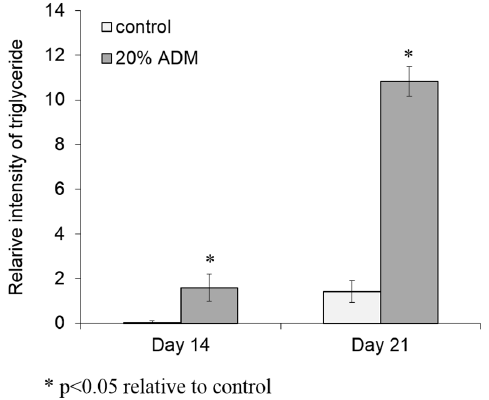
Figure 3. ADM increased triglyceride accumulation in human dermal fibroblasts, Hs68. Hs68 fibroblasts were treated with 20% ADM. After 14 and 21 days, the cellular TG contents were measured with TG adipogenesis kit at 570 nm. The results were expressed by the mean intensity of triglyceride compared to control ± standard deviation, n = 3.